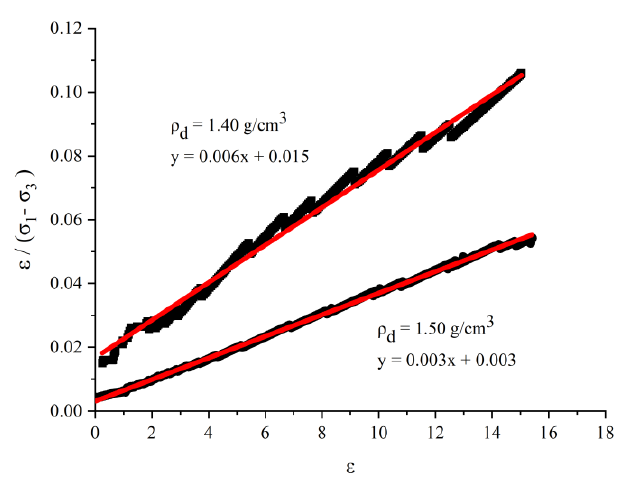
Figure 7. Fitting curve of diatomite soil with different dry density under 200 kPa confining pres- sure.